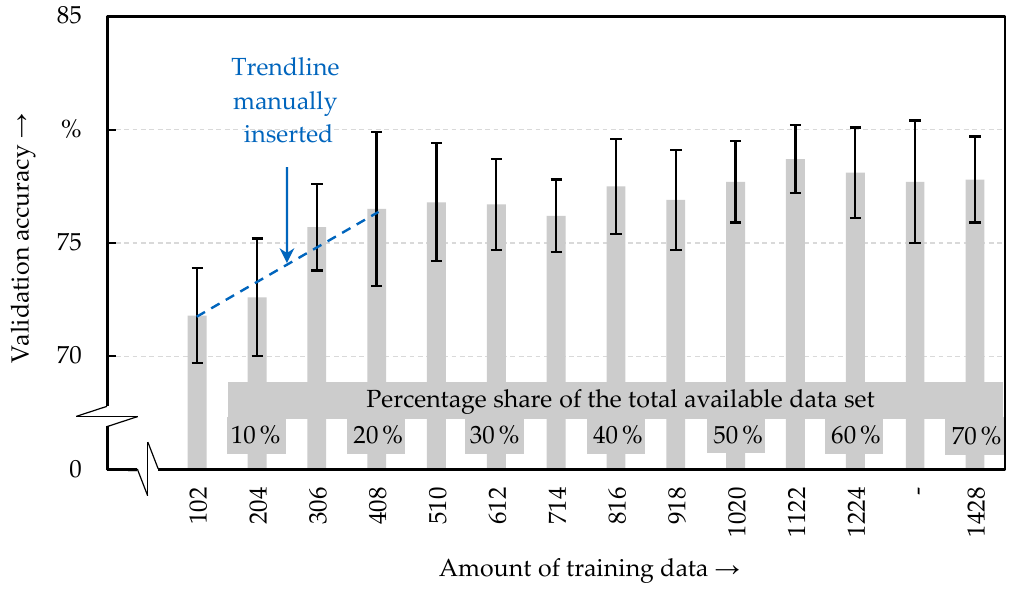
Figure 7. Validation accuracy depending on the amount of training data for the evaluation of the y -force using a CNN.